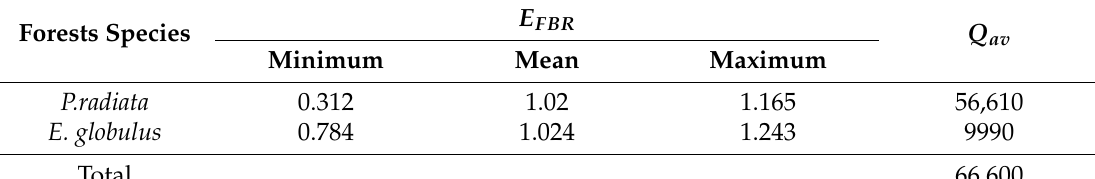
Table 5. Average values of annual forest biomass residue (dry matter) ( E FBR available residual forest biomass as dry mass ( Q av , Mg year − 1